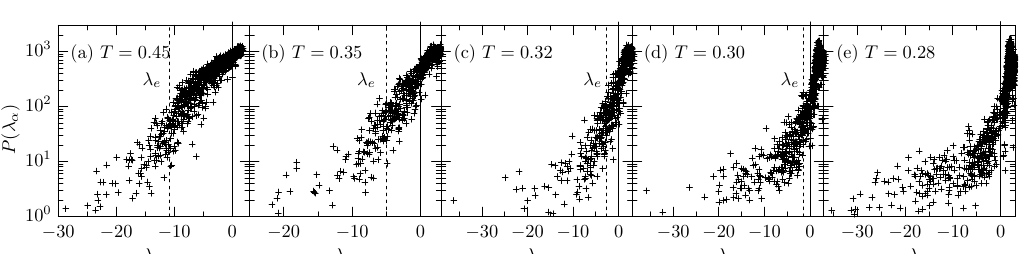
Figure 1: Scatter plots of the participation ratio for saddles at (a) T = 0.45, (b) T = 0.35, (c) T = 0.32, (d) T = 0.30, and (e) T = 0.28. In each panel, the solid and dotted lines correspond to λ = 0 and to the mobility edge λ